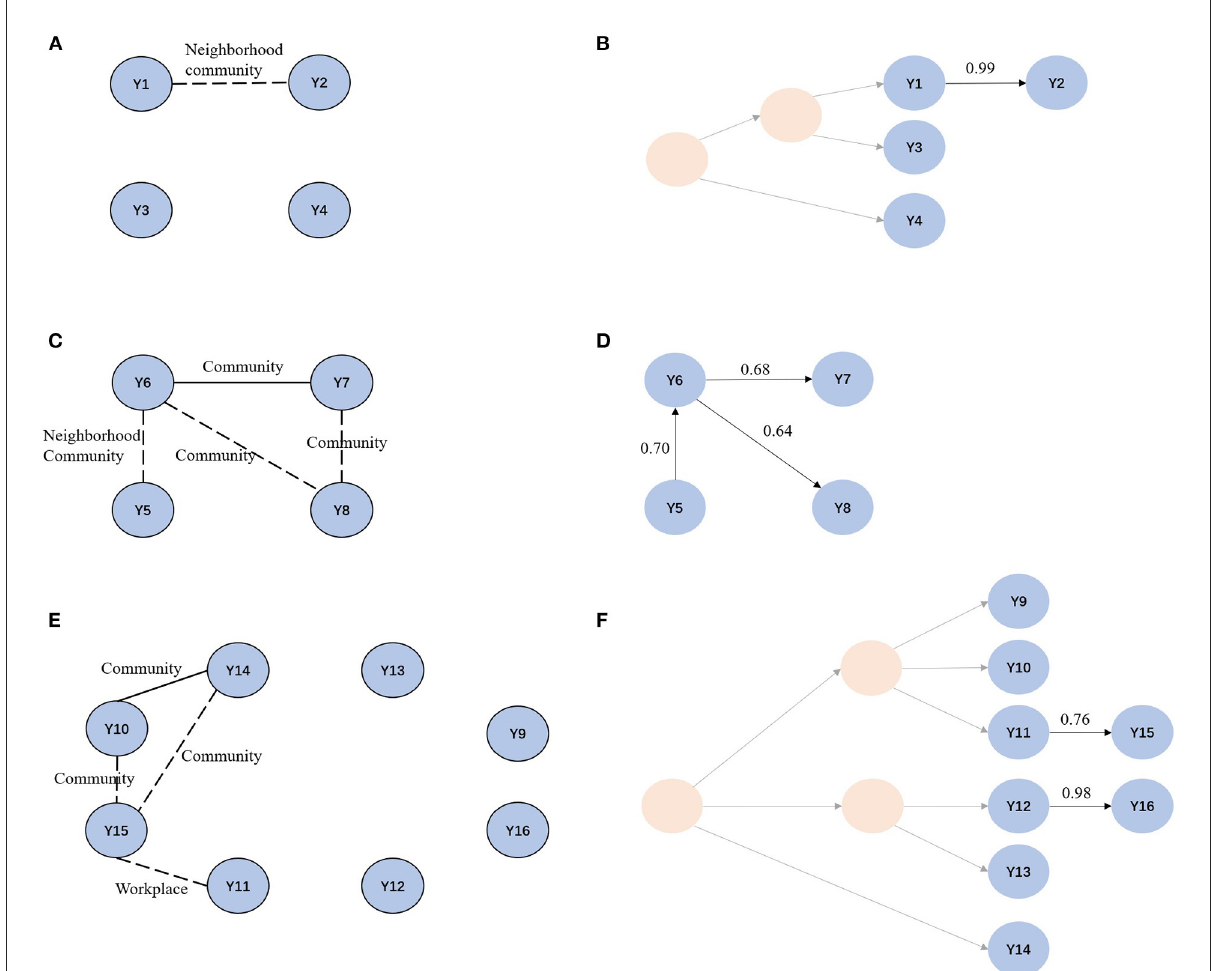
FIGURE4 Social network and transmission chain for cluster 3, cluster 4 and cluster 12. (A, C, E) Social network for cluster 3, cluster 4, and cluster 12. Solid line indicates confirmed epidemiological links. Dotted line indicates probable epidemiological links. (B, D, F) Transmission chain for cluster 3, cluster 4 and cluster 12. Light yellow circles represent missing